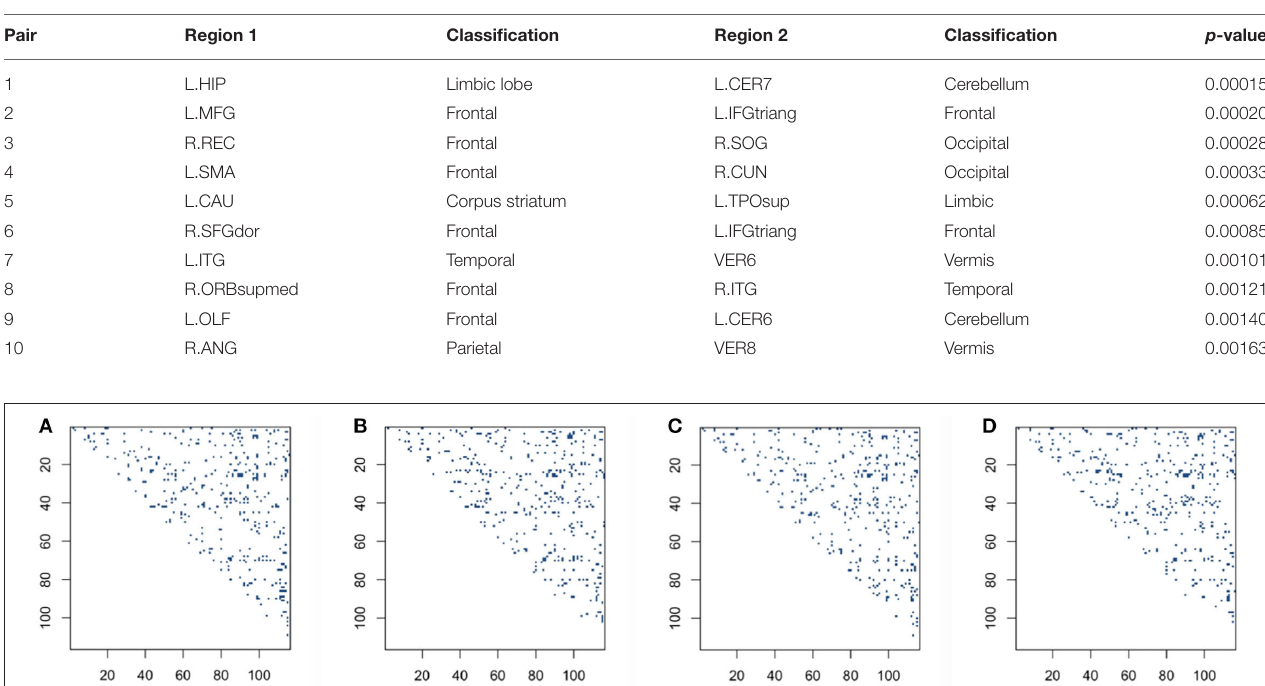
FIGURE 4 | Significant connection location detecting for sparse correlation and sparse covariance estimation method: (A) sparse correlation based on original blood oxygen level dependent (BOLD) signals; (B) sparse correlation based on low-rank matrices; (C) sparse covariance estimation based on original BOLD signals; (D) sparse covariance estimation based on low-rank